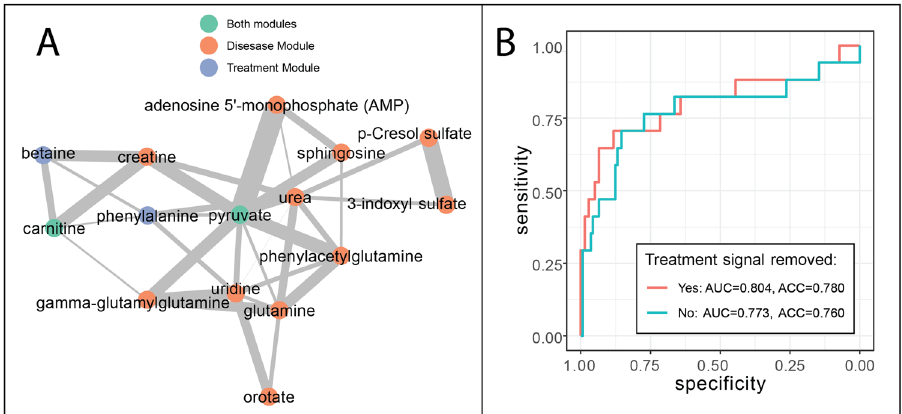
Figure 4. Impact of citrulline supplement on disease-specific network modeling ornithine transcarbamylase (OTC) deficiency. ( A ) Treatment module overlaps with main disease module for OTC deficiency and are well- connected. ( B ) Prediction performance of OTC deficiency model before and after removal of treatment